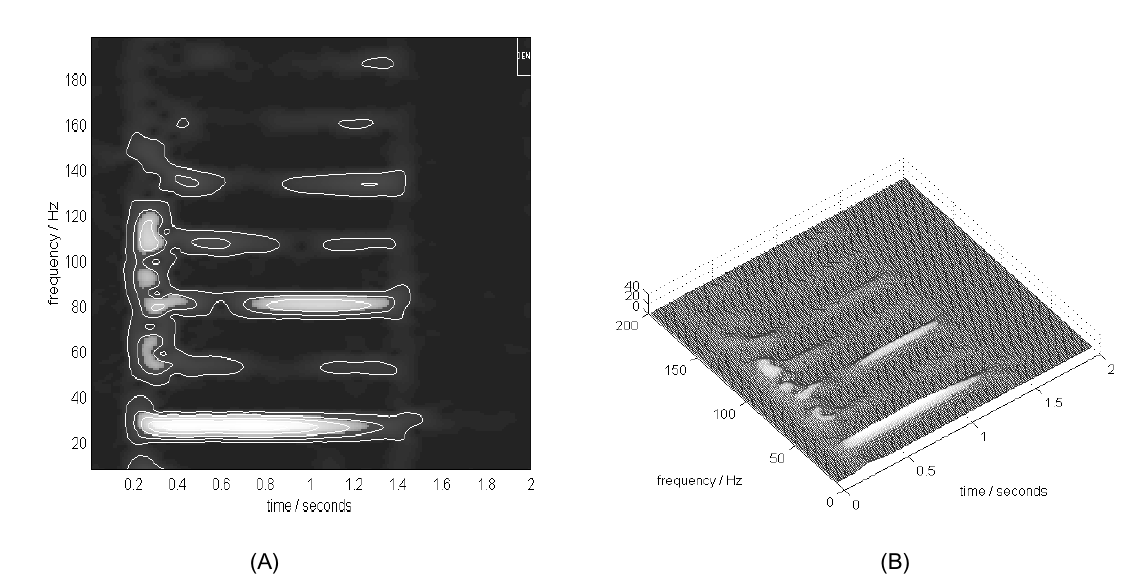
Fig. 6. (A) Time-frequency map of the changing frequency composition of the top signal, (B) Corresponding mesh diagram for the contour plot in Fig. 6(A).